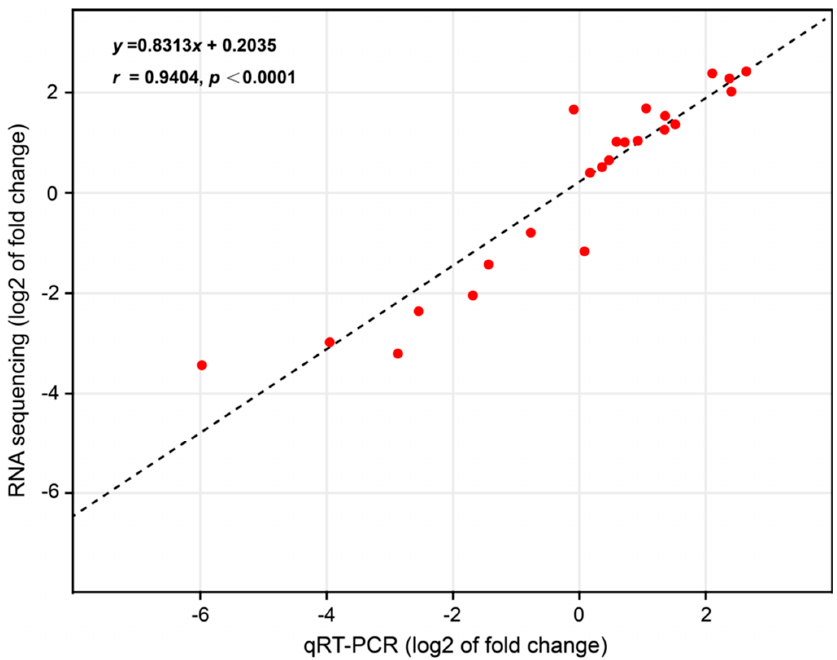
Figure 5. The Pearson correlation analysis of RNA sequencing data and qRT-PCR results for the 20 selected DEGs and 1 non-DEG between sk and Dazao. Each red point denotes a value of fold change of expression level in the sk mutant compared to the wild-type Dazao. The fold-change values were transformed by log10. All DEG genes were subjected to Kyoto Encyclopedia of Genes and Genomes (KEGG) 53 KEGG pathways (Supplementary Table S4). The top 20 enrichment KEGG terms were drawn as a